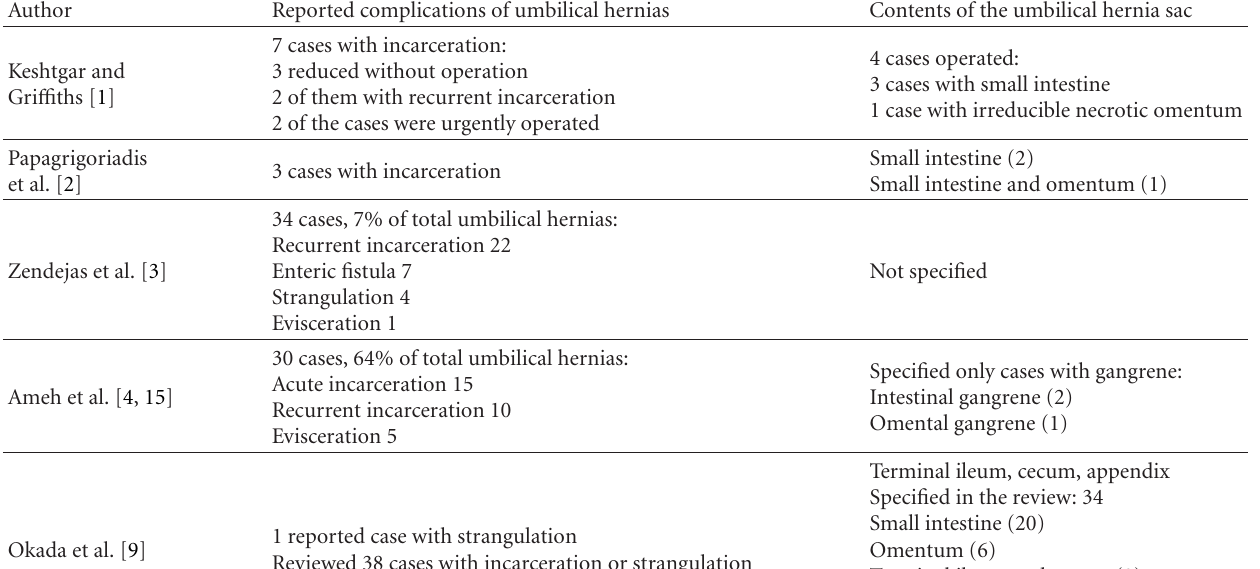
Table 1: Reported cases and sac contents of incarcerated umbilical hernias in